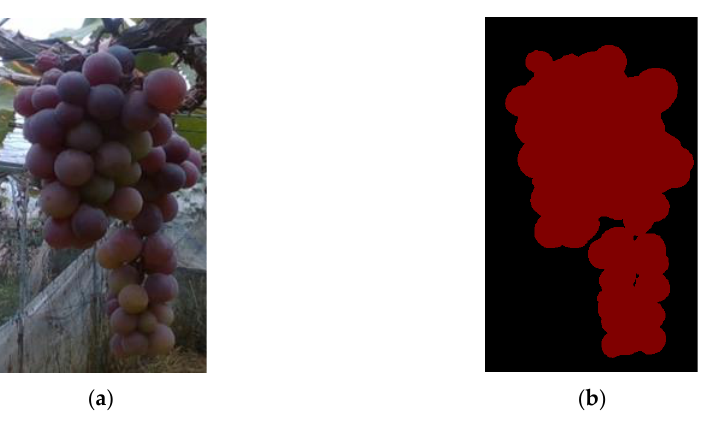
Figure 7. Accuracy and loss curves obtained on the training dataset. ( a ) The accuracy curve, and ( b ) the loss curve.